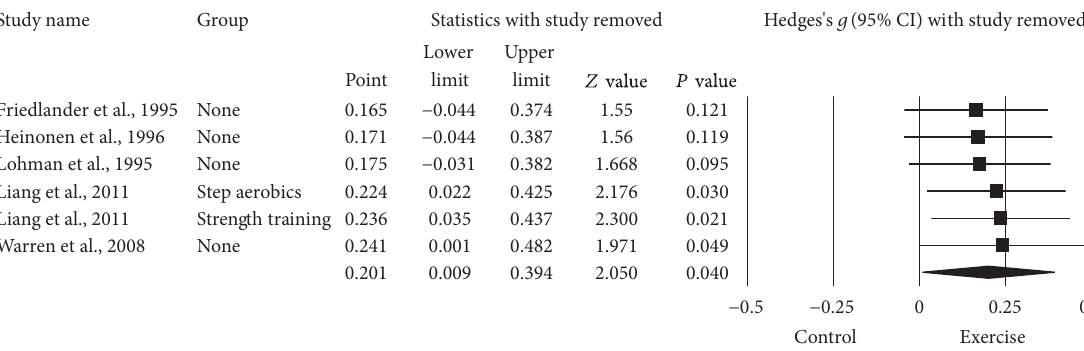
F 6: In�uence analysis for changes in LS BMD. In�uence analysis for point estimate standardized effect size changes ( each corresponding study deleted from the model once. e black squares represent the standardized mean difference ( right extremes of the squares represent the corresponding 95 con�dence intervals. e middle of the black diamond represents the overall standardized mean difference ( ) while the le and right extremes of the diamond represent the corresponding 95 Results are ordered from smallest to largest values of . Negative results favor control groups while positive results favor exercise groups. % 𝑔𝑔 𝑔𝑔